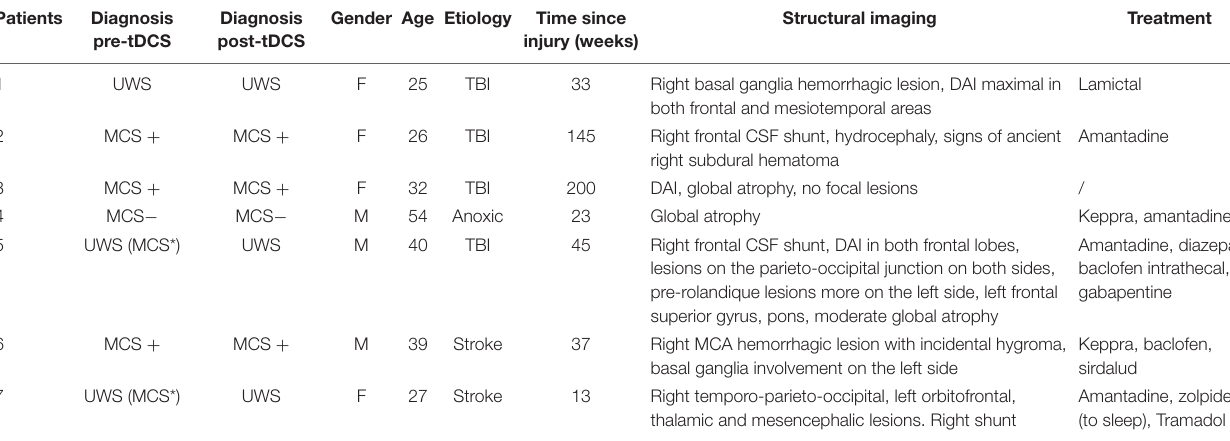
TABLE 1 | Demographical and clinical data of patients with disorders of consciousness (DOC).